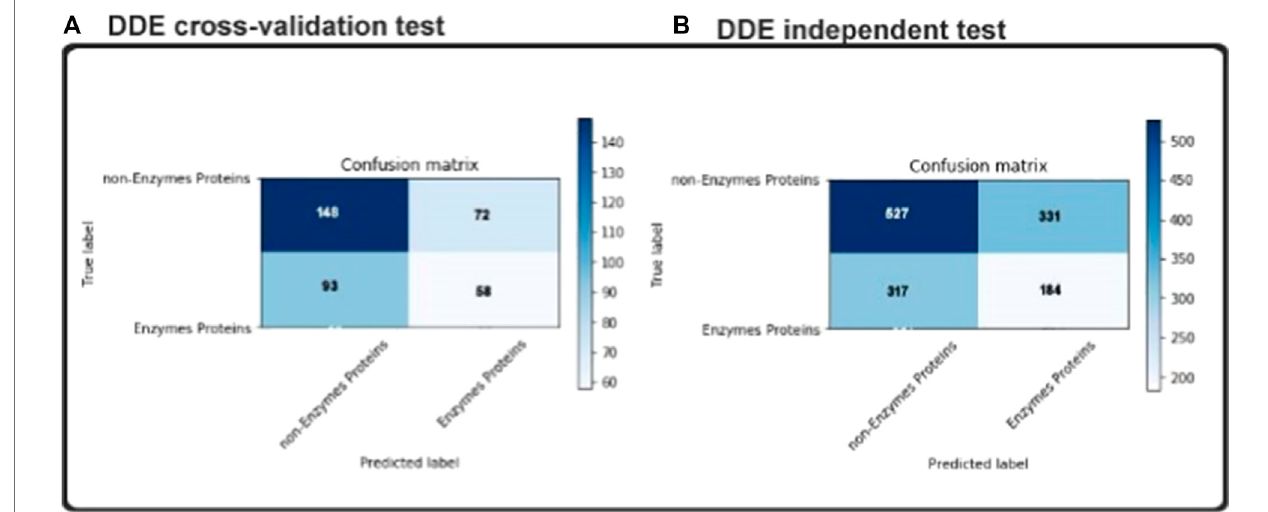
FIGURE 6 | Confusion matrices of: (A) independent test (B) cross-validation test.